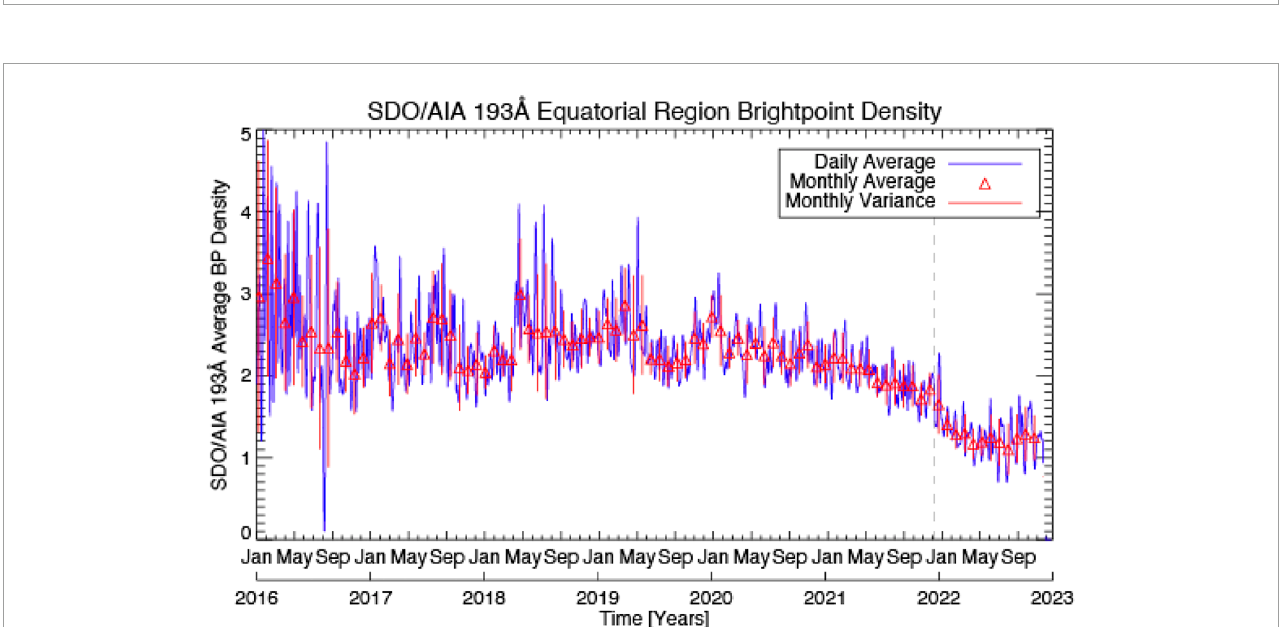
FIGURE 4 Variation of the equatorial (averaged over ± 3°) BP density since 2016, cf. Figure 2B . We contrast the daily average values (blue) with the monthly averages and variances (red).